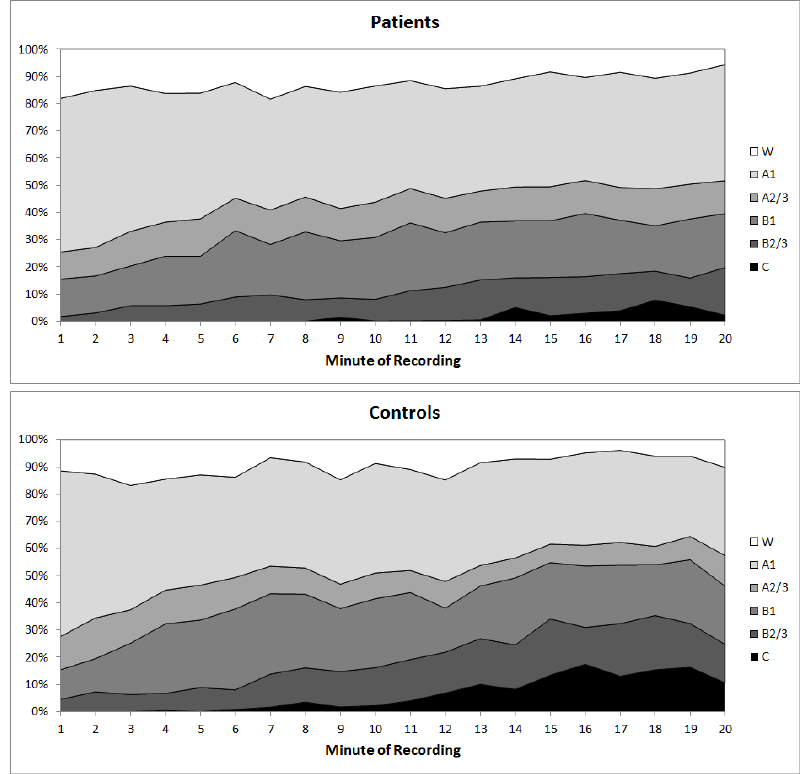
Figure 2. Time-course of EEG arousal stages across the 20-min resting EEG in insomnia patients (above) and healthy controls (below).